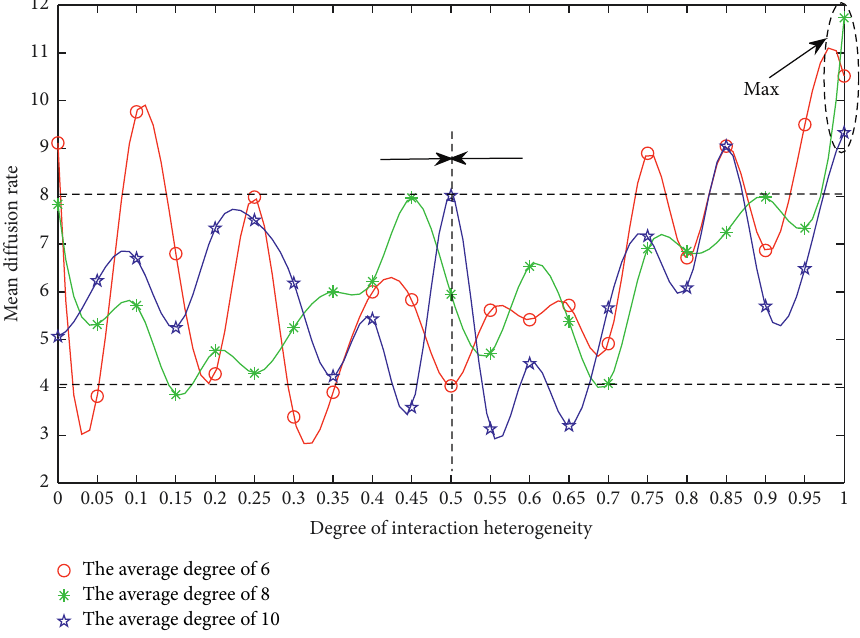
Figure 10: Influence of interaction heterogeneity on mean diffusion rate based on different network